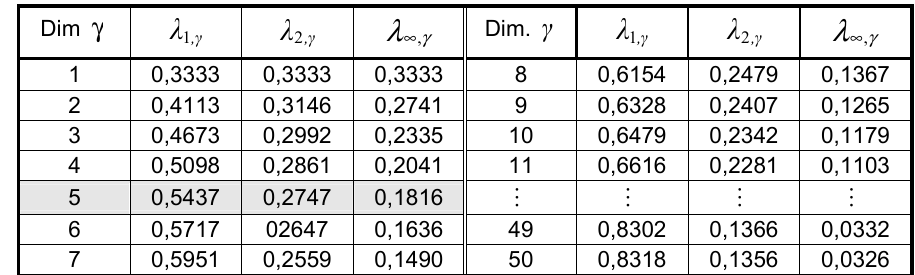
Таблица 4 – Значения коэффициента линейной функции Lp метрики (Yoon,1987) Table 4 – Values of the coefficients of the linear combination of the Lp metrics functions